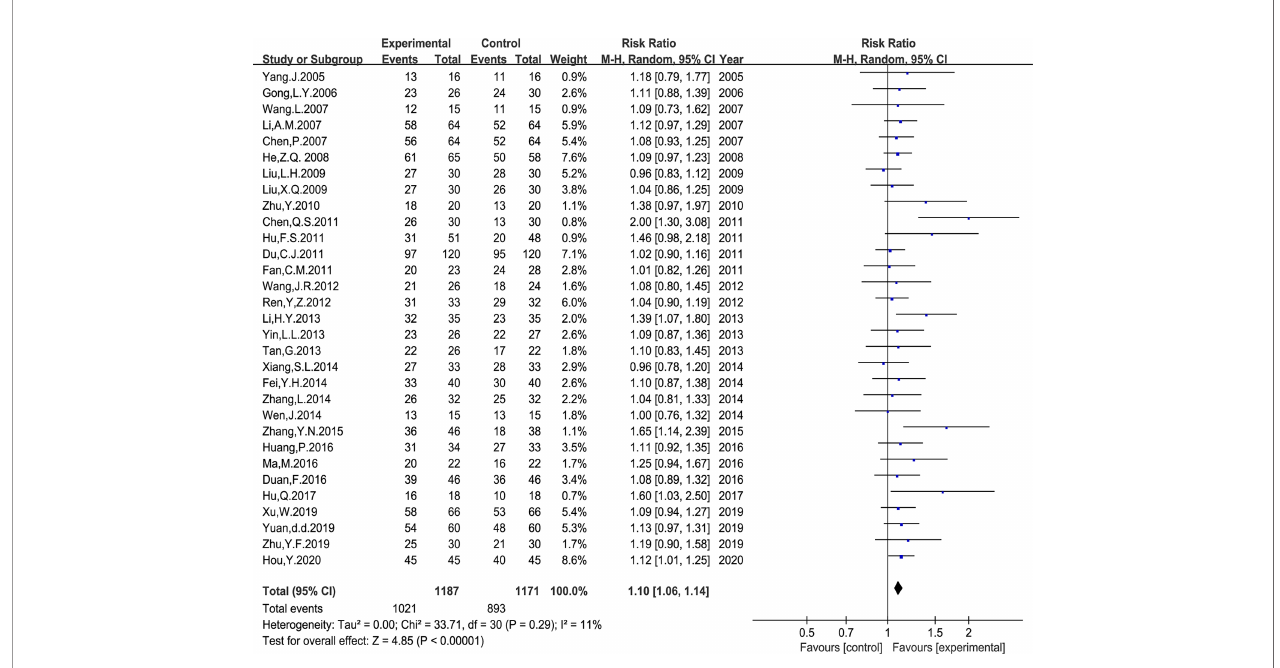
FIGURE 4 | Meta-analysis results of disease control rate (DCR) between the two